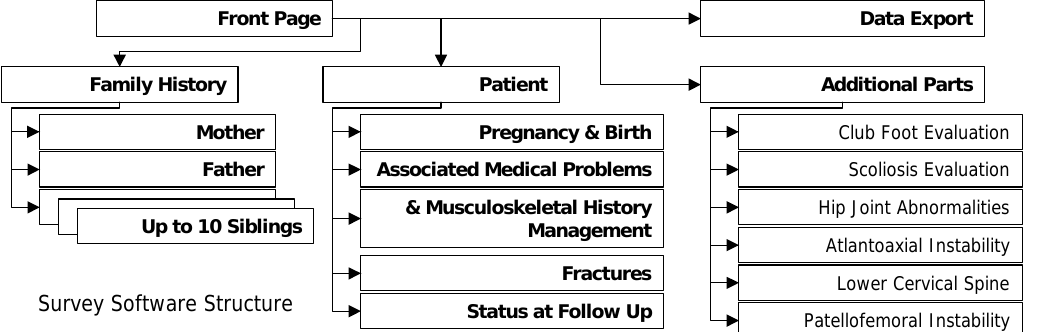
FIGURE 1. An overview of the information collected on each subject.